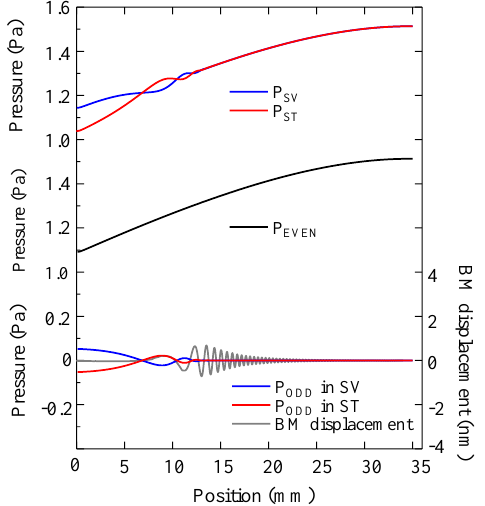
Figure 8. Analysis of an ear with severe round window atresia ( E = 10 GPa). The upper graph shows the sound pressure levels in the scala vestibuli (in blue) and scala tympani (in red). The middle graph shows the sound pressure level of the even mode (in black). The lower graph presents the sound pressure levels of the odd modes in the scala vestibuli (in blue) and scala tympani (in red), and the displacement of the basilar membrane (in light gray) when a sinusoidal plane wave with a pressure level of 1 Pa and a frequency of 5000 Hz was excited at the oval window. The horizontal axis shows the position in the cochlea.